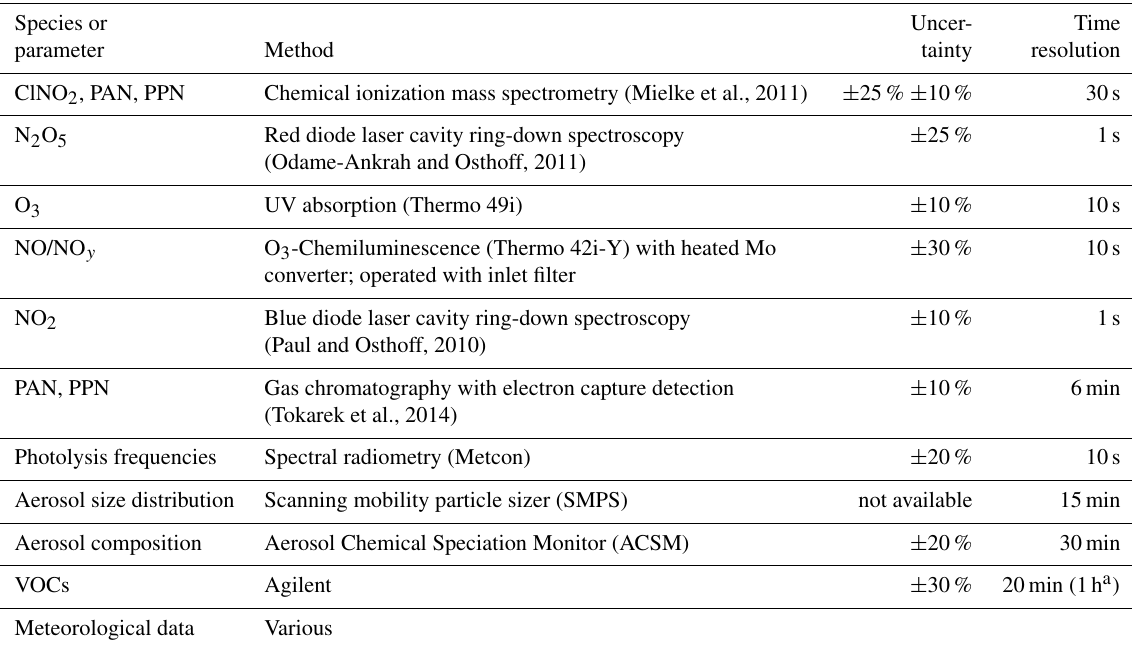
Table 1. Summary of measurement techniques deployed at T45 during the study. Species or Uncer- Time parameter Method tainty resolution ClNO 2 , PAN, PPN Chemical ionization mass spectrometry (Mielke et al., 2011) ± 25% ± 10% 30s ± 25% 1s N 2 O 5 Red diode laser cavity ring-down spectroscopy (Odame-Ankrah and Osthoff, 2011) O 3 UV absorption (Thermo 49i) ± 10% 10s ± 30% 10s NO/NO y O 3 -Chemiluminescence (Thermo 42i-Y) with heated Mo converter; operated with inlet filter ± 10% 1s NO 2 Blue diode laser cavity ring-down spectroscopy (Paul and Osthoff, 2010) ± 10% 6min PAN, PPN Gas chromatography with electron capture detection (Tokarek et al., 2014) Photolysis frequencies Spectral radiometry (Metcon) ± 20% 10s Aerosol size distribution Scanning mobility particle sizer (SMPS) not available 15min Aerosol composition Aerosol Chemical Speciation Monitor (ACSM) ± 20% 30min VOCs Agilent ± 30% 20min (1h a ) Meteorological data